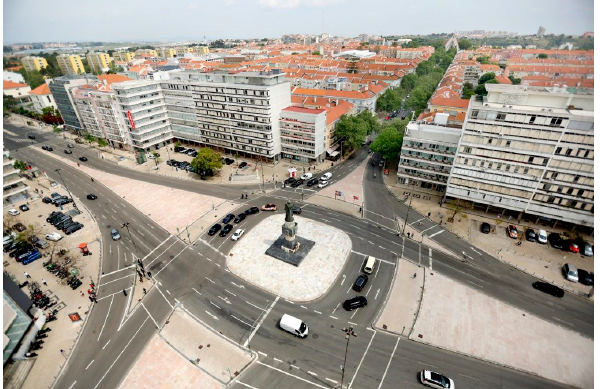
Figure 4. Alvalade Square (X in Figure 3). Credits: Junta de Freguesia de Alvalade.